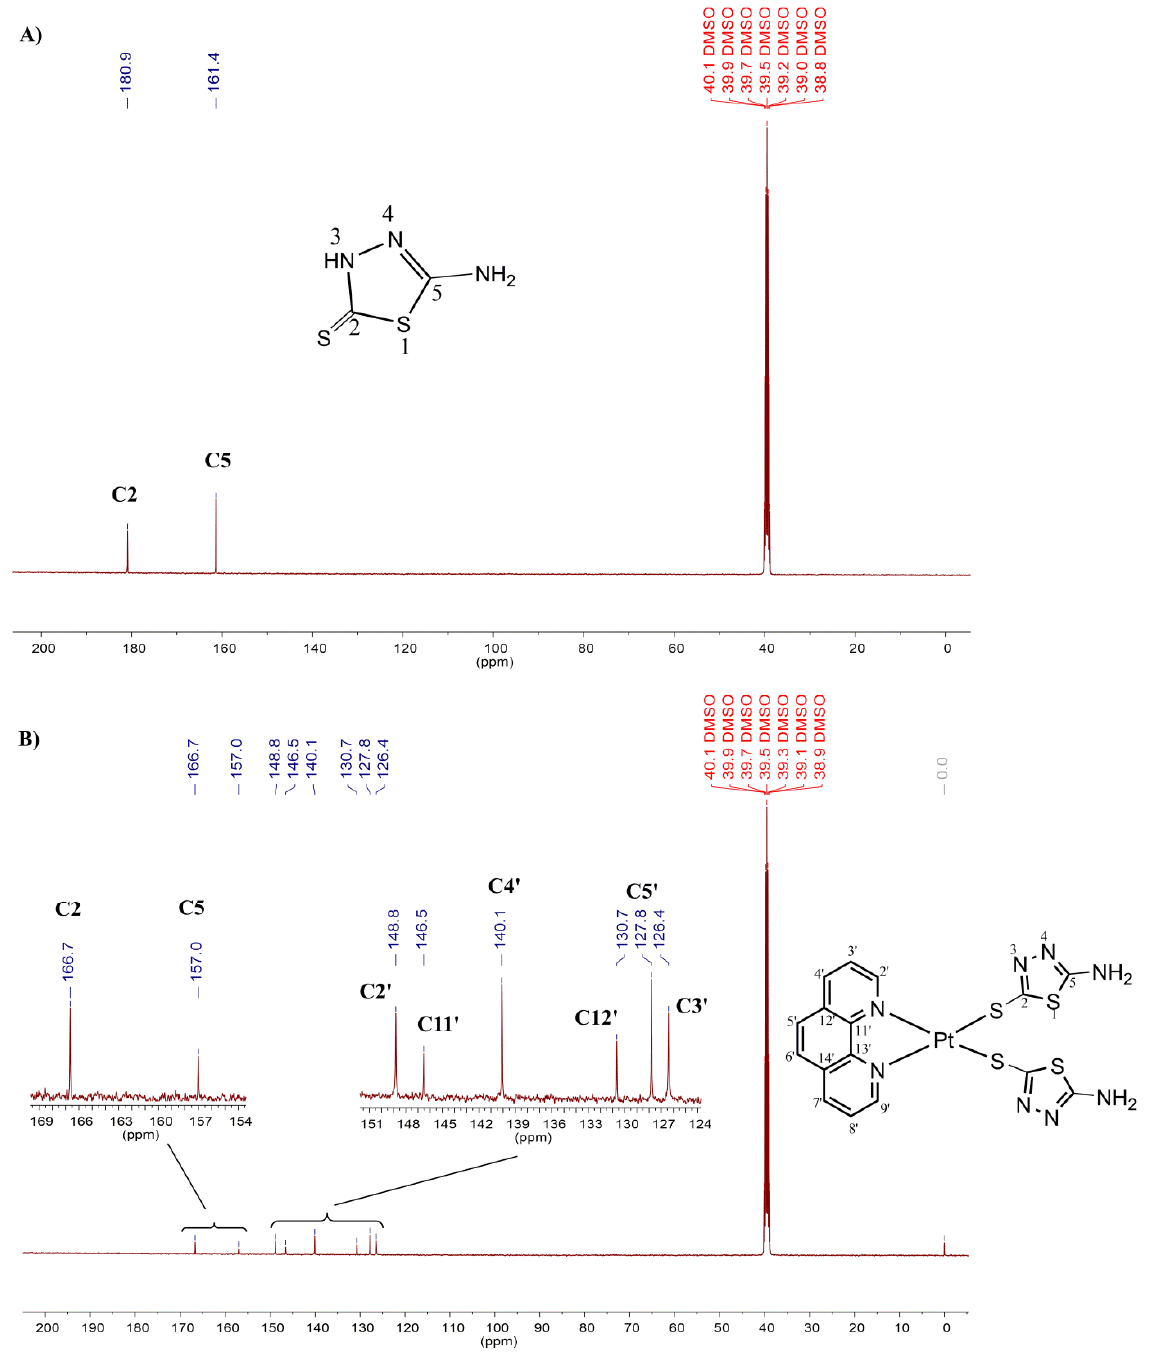
Figure 3. 13 C NMR spectrum (DMSO- d 6 , 100 MHz) of the ligand 5-amino-1,3,4-thiadiazole-2(3H)- thione ( A ) and of the complex I expanded from 124–151 (region assigned to carbons of the phenanthroline) and between 154–169 ppm (region assigned to carbons of the thiadiazole rings) ( B ). 2.2. Epidemiological and Antimicrobial Resistance Study of the Bank of 235 Strains of C. Jejuni The frequencies and percentages of the resistance profiles found for the 235 strains of C. jejuni are described in Table 2 and broken down according to the epidemiological Resistance to CIP (121/235, 51.5%) was significantly higher than ERY (83/235, 35.3%). characteristics evaluated. Of the 235 strains, 53 (22.55%) showed mutual resistance to CIP Nevertheless, the results of MIC 50 and MIC 90 demonstrated the need for expressive and ERY, 68 (28.93%) were resistant to CIP only, 30 (12.76%) to ERY only, and 84 (35.74%) were sensitive to both antibiotics. Furthermore, we observed that ERY-only resistance was lower than the other profiles identified ( p = 0.0075, Fisher’s test) and that the profile including sensitive strains was the most prevalent ( p = 0.0023, Fisher’s